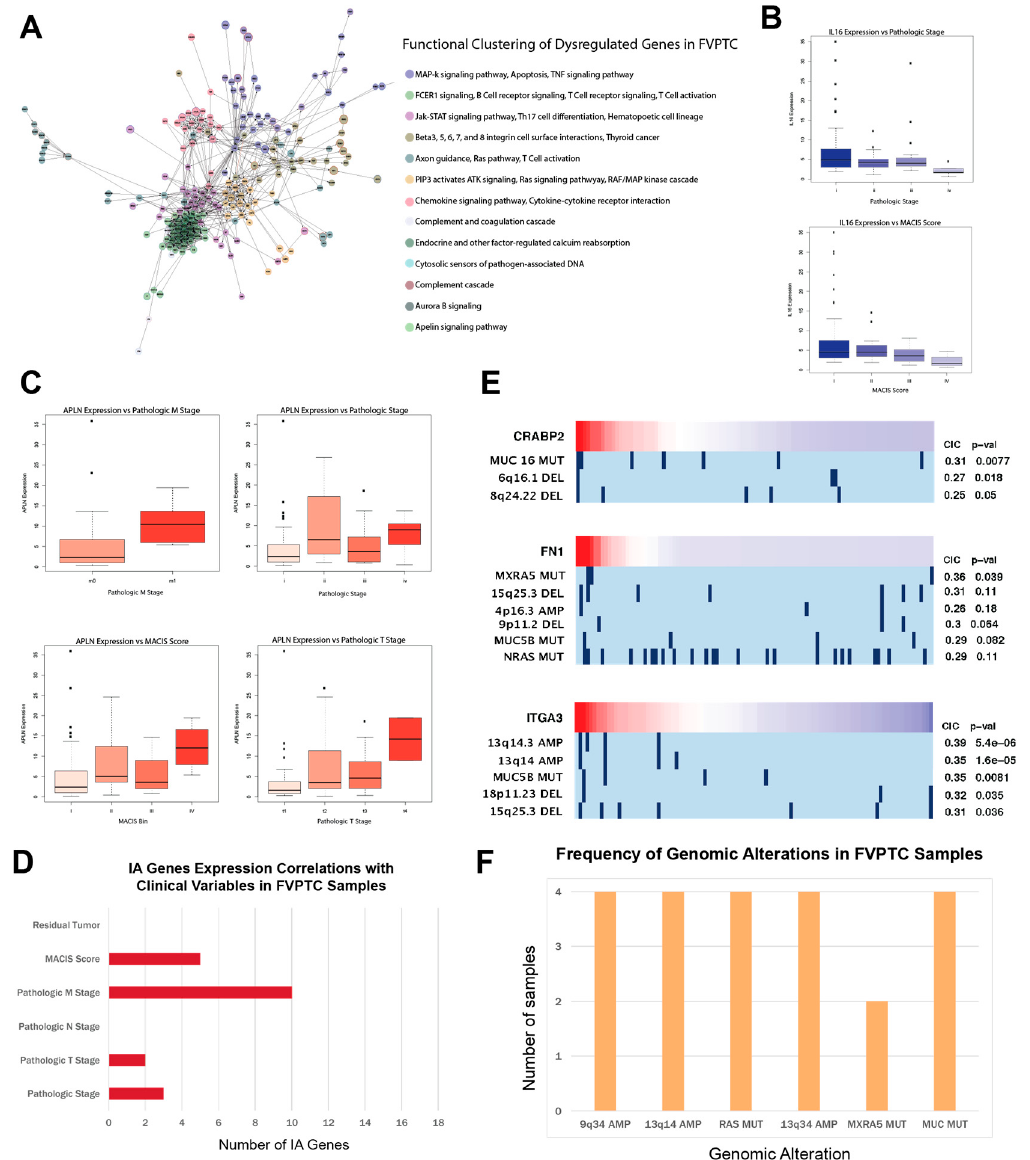
Figure 3. Pathways and genes characterizing the FVPTC dysregulation landscape. ( A ) ReactomeFIViz functional clustering analysis for dysregulated genes in FVPTC vs normal samples. ( B ) Boxplots presenting association of IL16 expression with clinical variables for FVPTC patients. ( C ) Boxplots presenting association of APLN expression with clinical variables for FVPTC patients. ( D ) Barplot documenting number of CA/IA genes that correlated with six clinical variables in FVPTC. ( E ) REVEALER plots illustrating genomic alteration associated with dysregulated genes in FVPTC. ( F ) Barplot depicting number of samples that possess the most common genomic alterations.